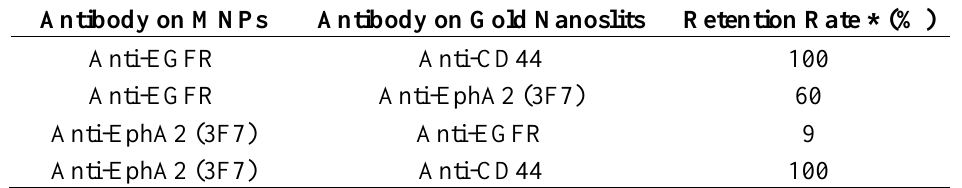
Table 1. Various combinations of the candidate antibodies selected for the two